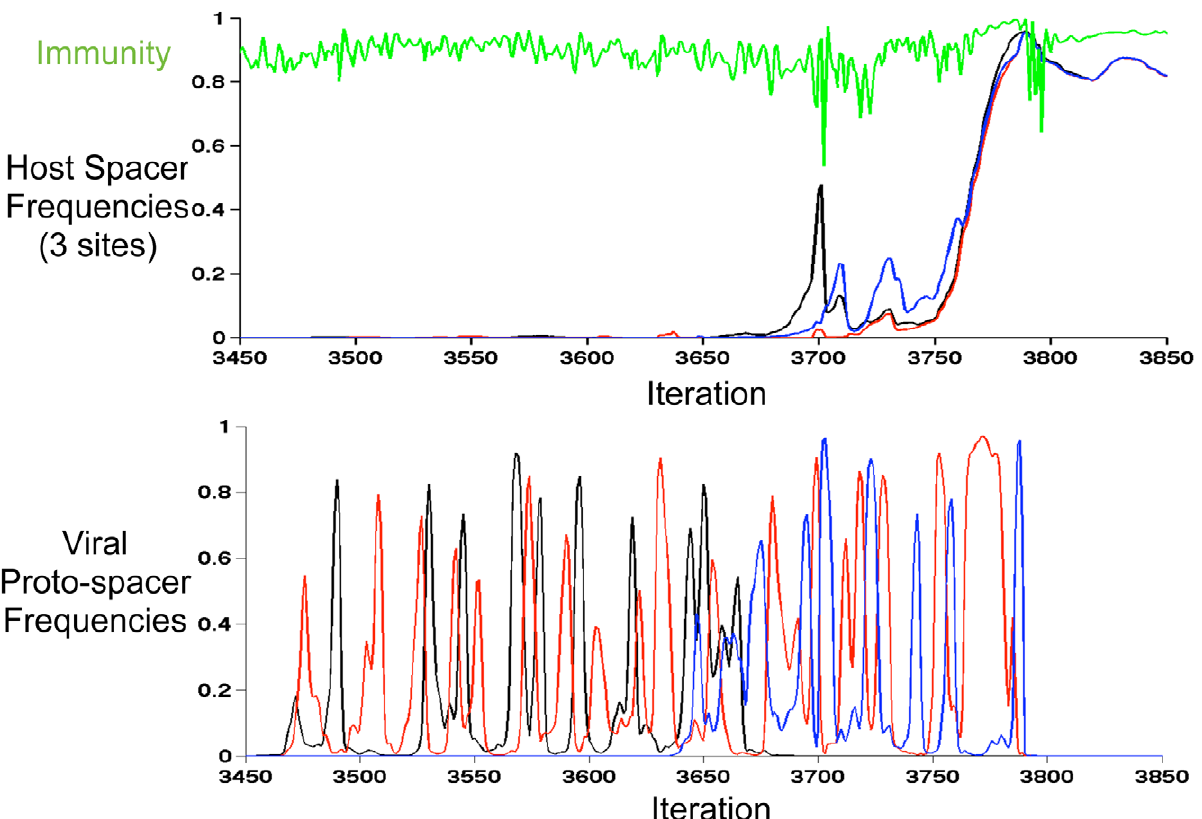
Figure 5. Sweep driven by spacer-mediated immunity against multiple viral sub-populations. In the upper panel, the frequency of the sweeping spacer identified in Figure 4B is again shown in black. Also tracked, are the two adjacent spacers added by the black spacer’s successful host line. The frequencies of these adjacent spacers in their respective locus columns are shown in red and blue. In green, we track the fraction of immune virus-host interactions. The lower panel shows the frequencies of the three corresponding proto-spacers in the viral population. The inverse fluctuations in viral proto-spacer frequencies show that the viruses fail to lose all three proto-spacers on a single line until just prior to iteration 3800, after the sweep. The host line thus sweeps due to immunity to both viral sub-populations.